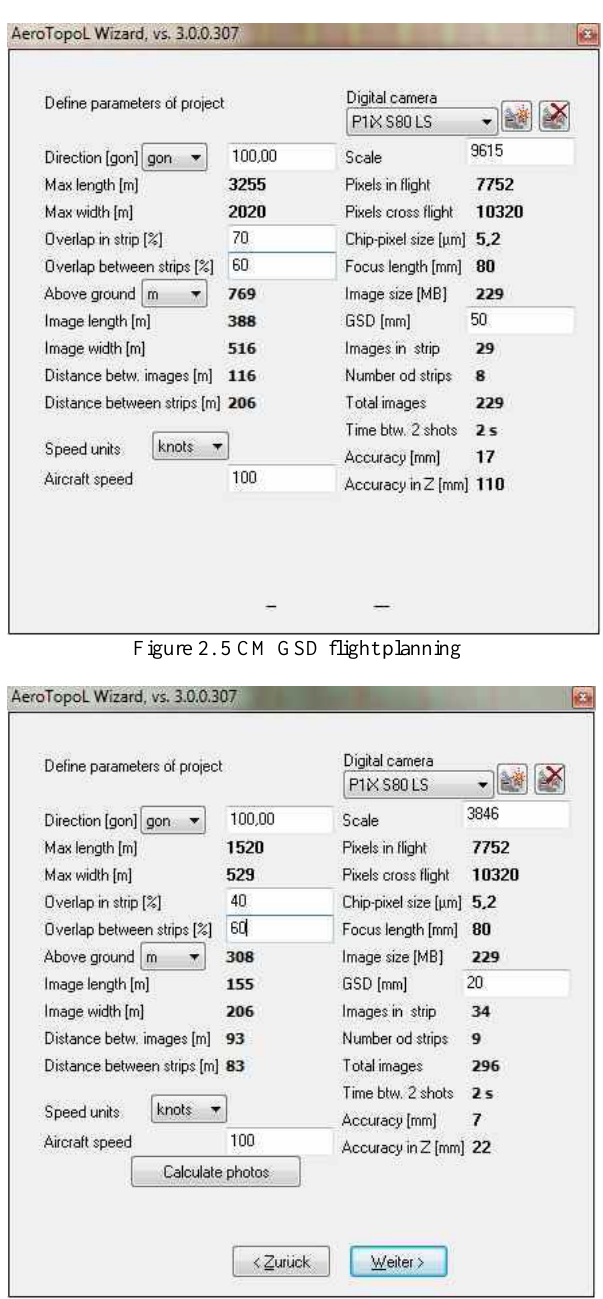
Figure 3. 2 CM GSD flight